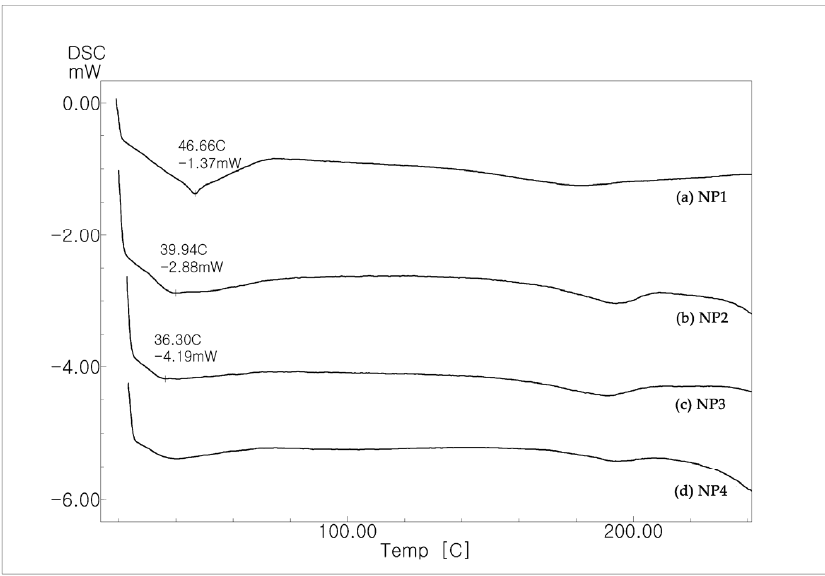
Figure 2. DSC analysis of NPs (a) NP1, (b) NP2, (c) NP3, (d) NP4. The major peaks are indicated for the DSC curve of each NP.